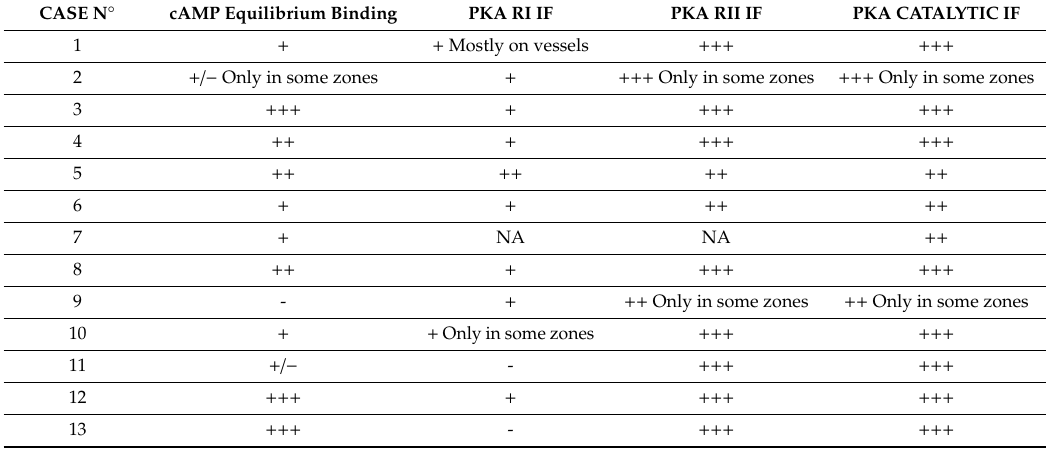
Table 1. Summary of results obtained with the fixation protocol that gives optimal results for each antigen. The intensity of equilibrium binding was evaluated in the best labelled immunofluorescent sections. Grading is a mean of values obtained in di ff erent repetitions of the experiment by two observers that independently scored the slides. IF: immunofluorescence. NA: not available, slices lost during processing. Grading: − : negative. − /+ : some positive trials, some negative. + : faint labelling. ++ : moderate. +++ : intense labelling. The relative intensity was evaluated for each